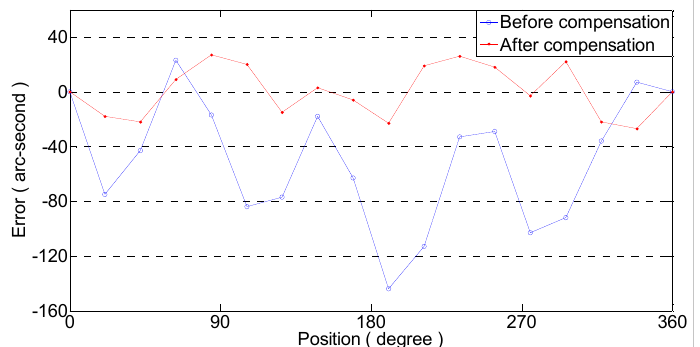
Figure 9. Errors of encoder before and after compensation.